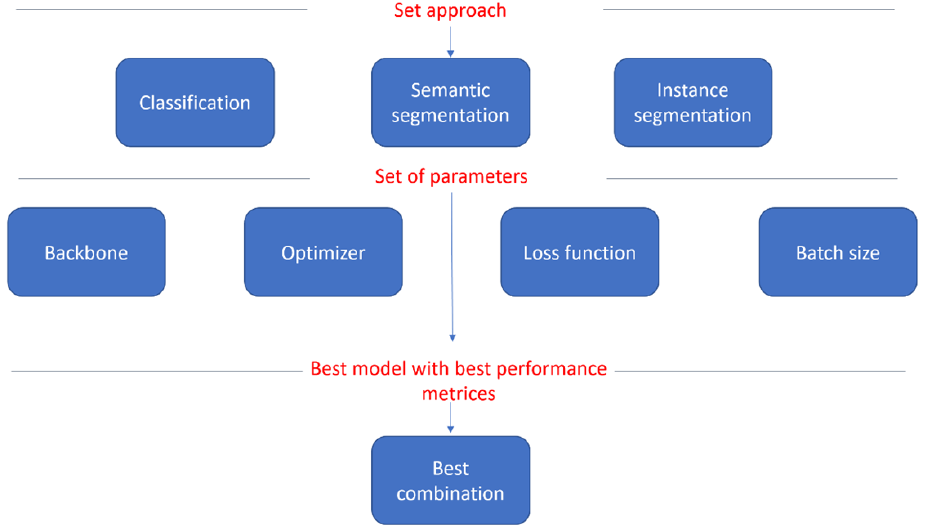
Figure 3. Best model selection